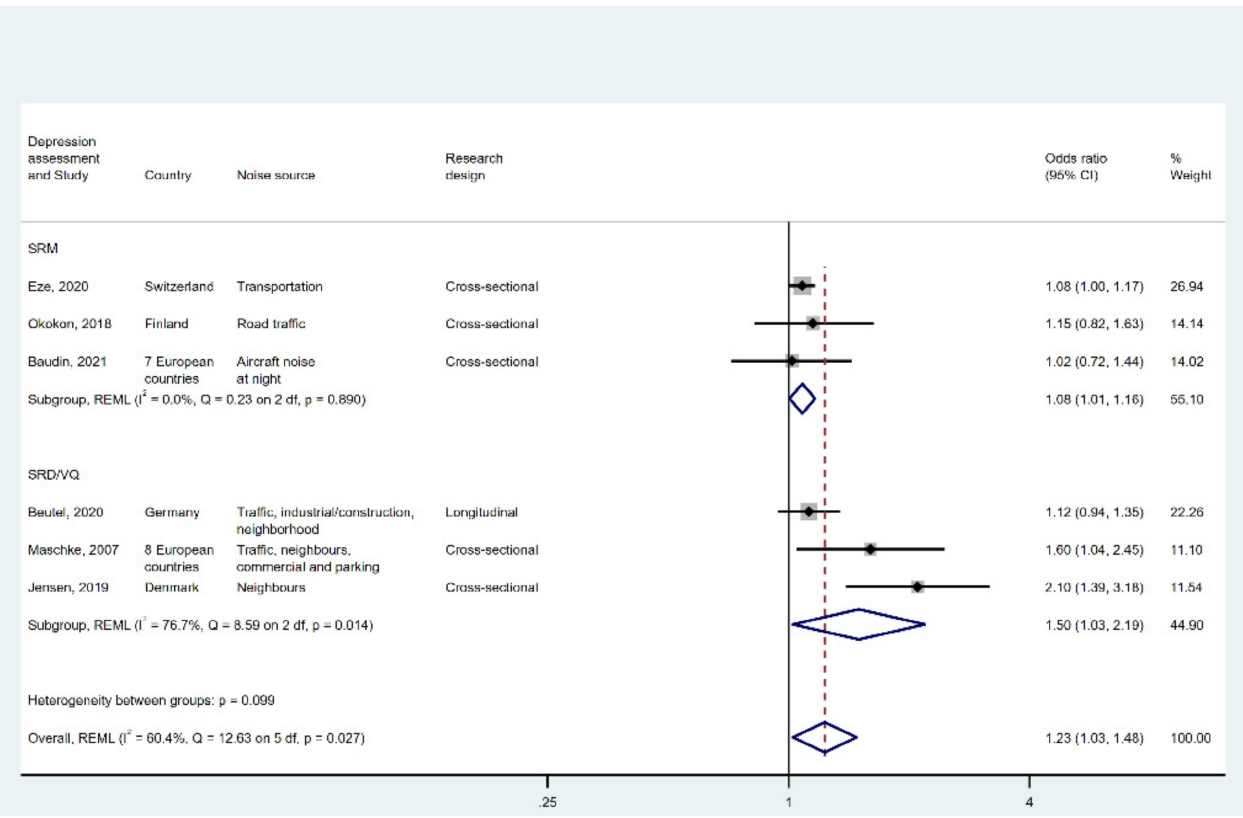
Figure 2. Forest plot displaying the link between high noise annoyance and depression. Note: weights and between-subgroup heterogeneity text are from random-effects